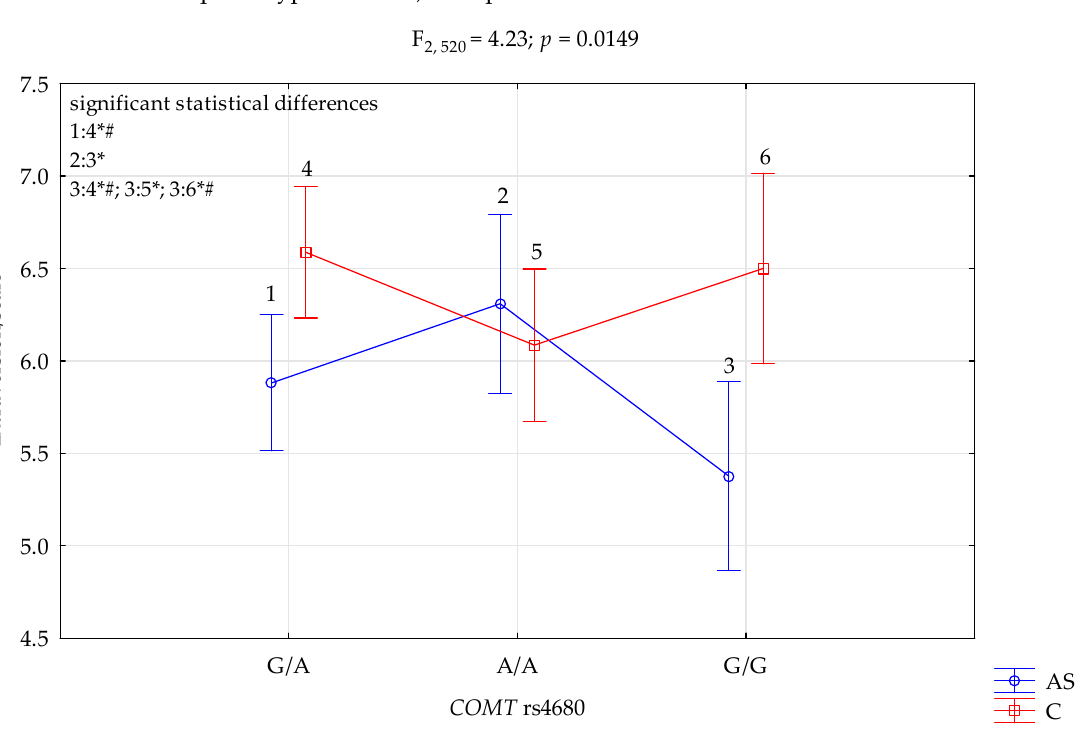
Figure 4. Interaction between the group of patients diagnosed with other stimulants dependence (AS)/Control (C) and COMT rs4680 and Extraversion scale. *—significant result, # Bonferroni correction was used, and the p -value was reduced to 0.0083 ( p = 0.05/6 (number of statistical tests conducted)).